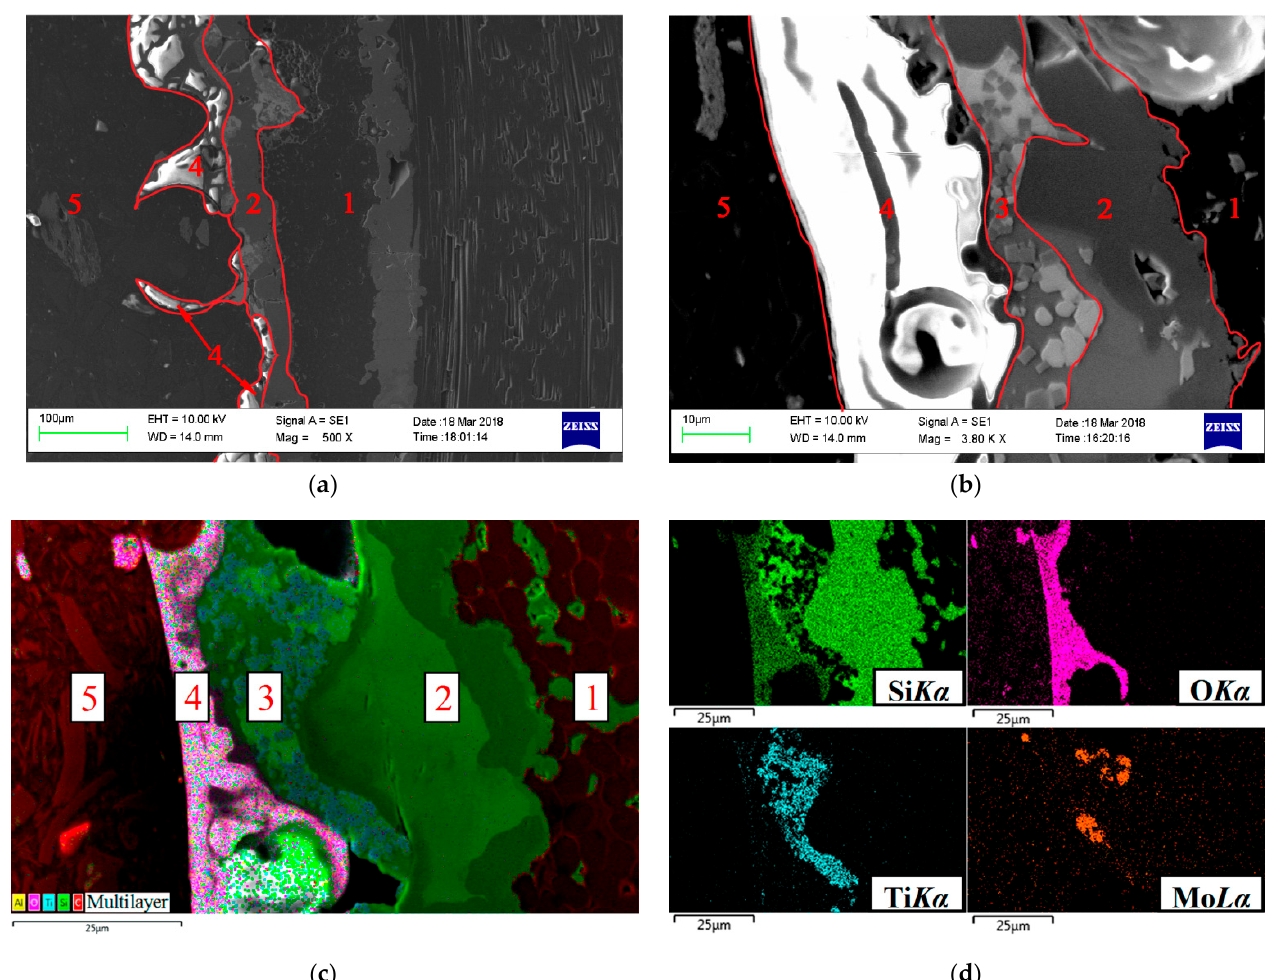
Figure 10. Microstructure ( a , b ) and distribution of elements in characteristic X-ray radiation ( c , d ) in cross-sections of Si–TiSi 2 –MoSi 2 –TiB 2 –CaSi 2 coating areas after firing tests according to the regime shown in Figure 5, a: ( a ) in the vicinity –of the epicenter of the flow; ( b ) at a distance of 10 mm from the critical point; ( c , d ) at a distance of 7.5 mm from the critical point: 1—substrate, 2—SiC-backing layer, 3—unoxidized coating, 4—oxide film, 5—resin.